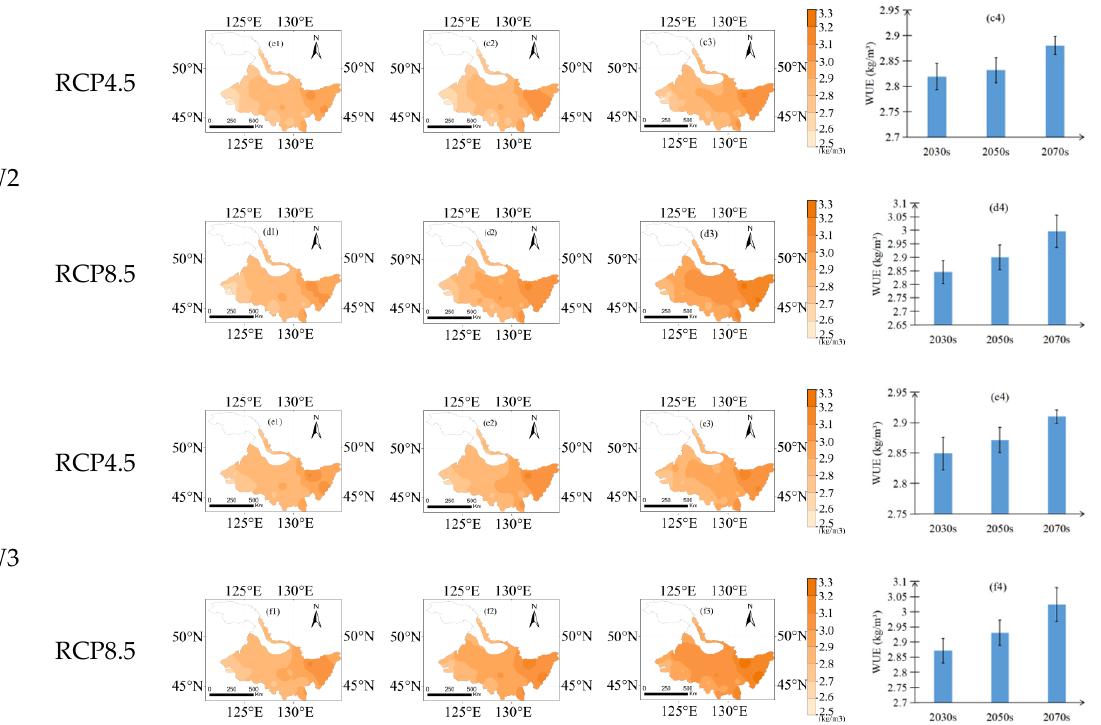
Figure 9. Spatial and temporal distribution of maize WUE for the multi-GCM ensemble under different irrigation schedules (( a1 – a4 , b1 – b4 ) W1, ( c1 – c4 , d1 – d4 ) W2, ( e1 – e4 , f1 – f4 ) W3) in the 2030s, 2050s, and 2070s with two RCPs.